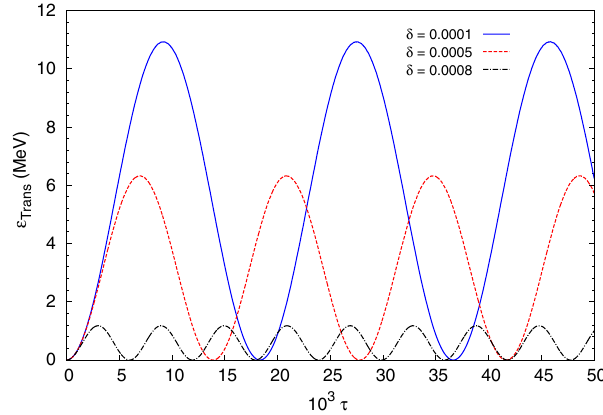
FIG. 4. Temporal evolution of the particle trajectory along three space dimensions (a) is plotted along with the trajectory in the x - z plane (b), y - z plane (c), and x - y plane (d). Here, we have considered the phase modulation factor (cid:3) ¼ 0 : 5